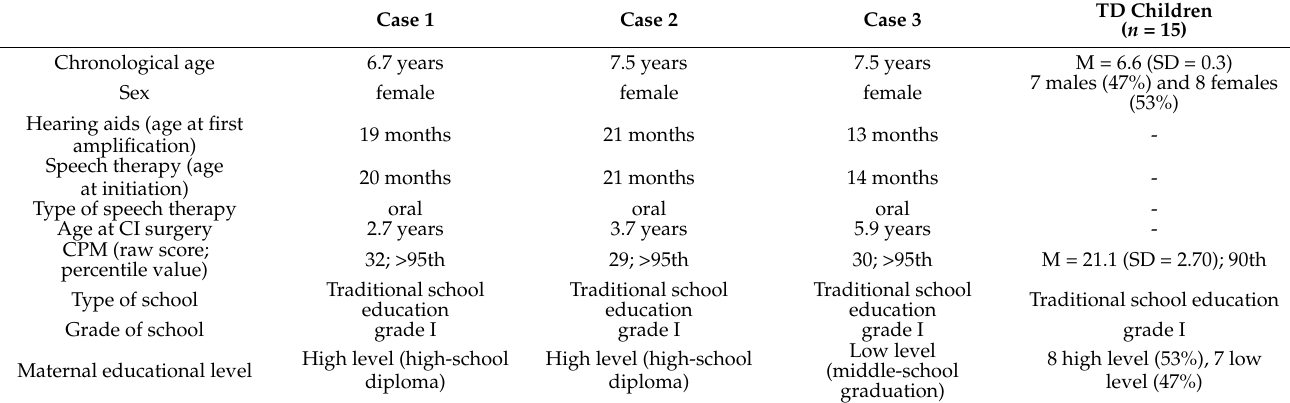
Table 1. Clinical data and nonverbal scores from CPMs (Colored Progressive Matrices) for each of the three deaf children and the control